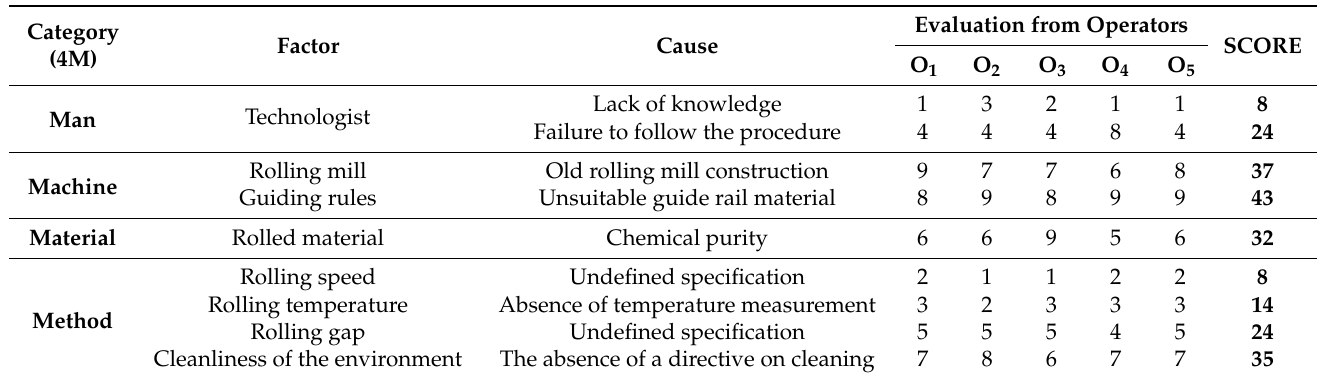
Table 1. Processing of potential causes—4M categories. Source: own